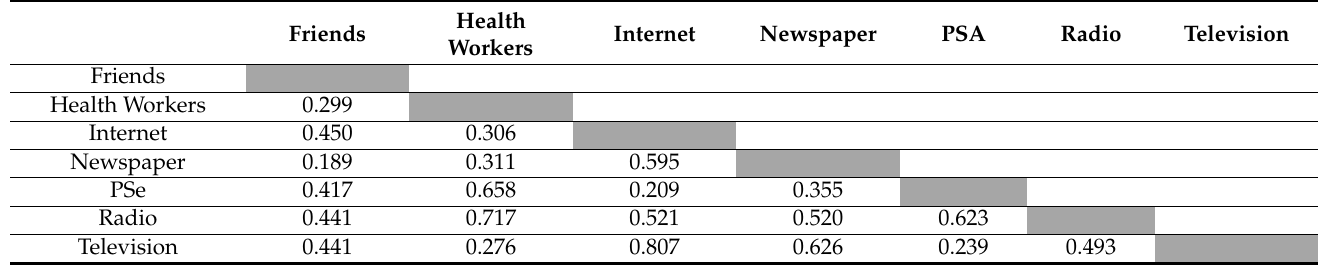
Table 7. Discriminant validity.